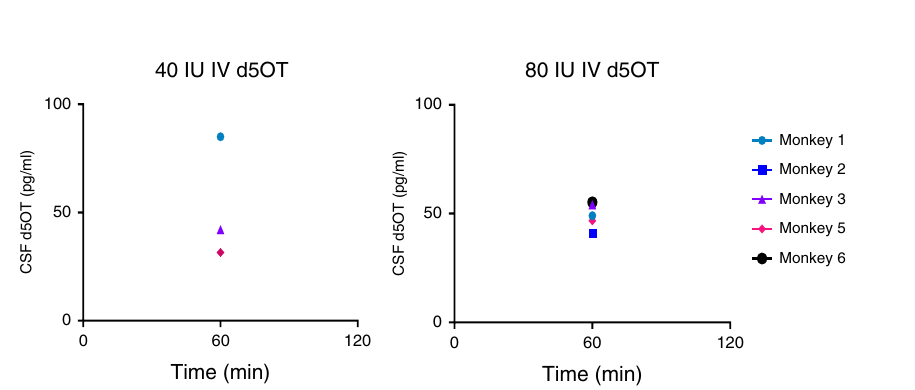
Fig. 1 Cerebrospinal fl uid (CSF) d5 oxytocin (OT) concentrations: time course of d5OT concentrations in monkey cerebrospinal fl uid (CSF) after intravenous (IV) administration of 80 and 40 IU d5OT ( N = 6). No d5OT was detected after intranasal (IN) administration of 80 IU d5OT. Limit of quanti fi cation = 100 pg/ml.